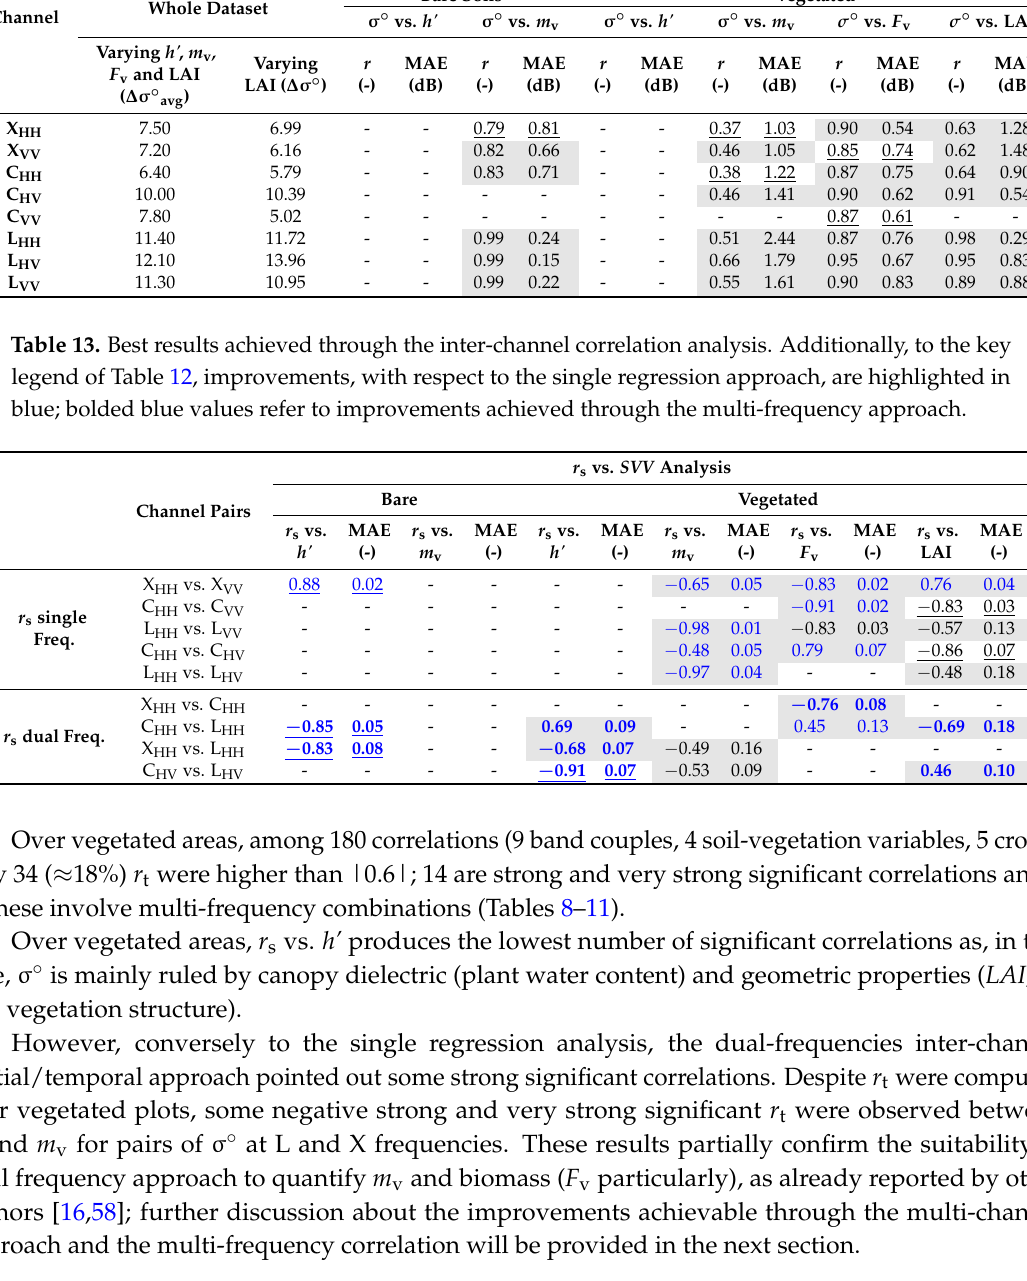
Table 12. Best results achieved through the dynamic and correlation analyses; significant correlations are highlighted in light-grey, quasi -significant correlations are underlined; other correlations are not reported; for each correlation MAE is also reported.